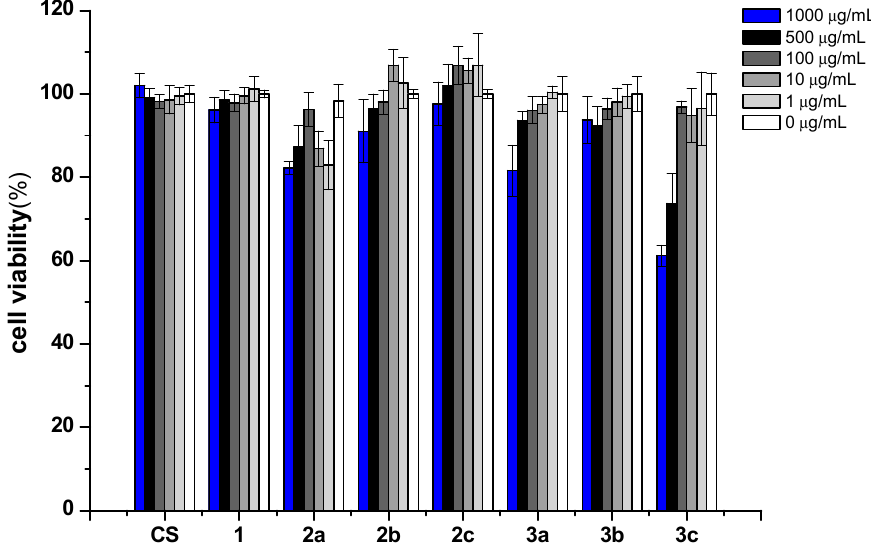
Figure 8. The cytotoxicity of chitosan and chitosan derivatives on L929